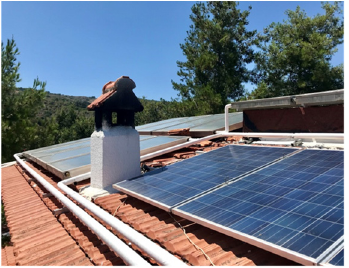
Figure 4. Solar collectors on the